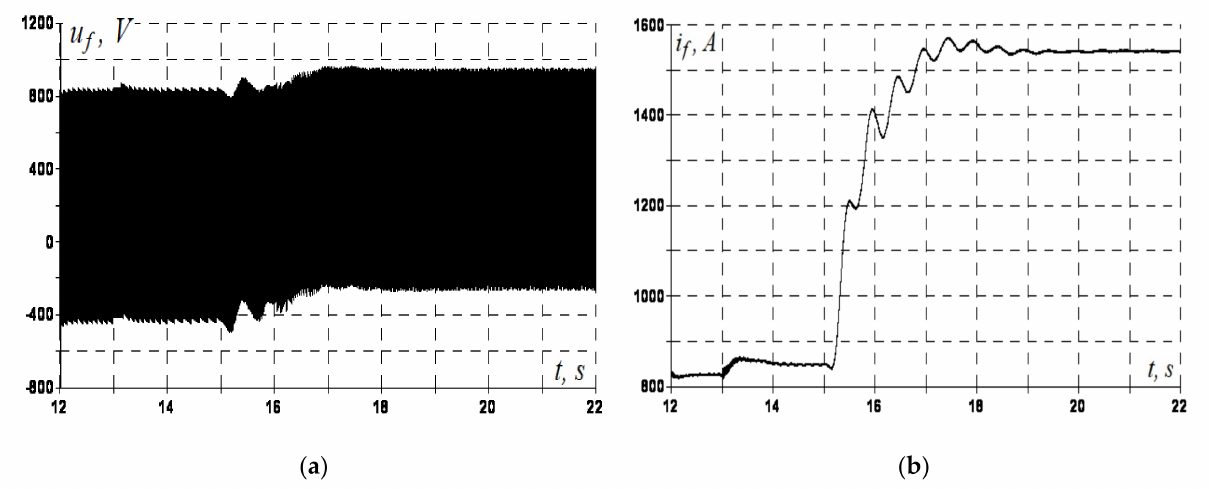
Figure 9. ( a ) Field voltage ( u f ); ( b ) field current ( i f ) for connecting the generator to the power grid (at 13 s) and the active power loading (at 15